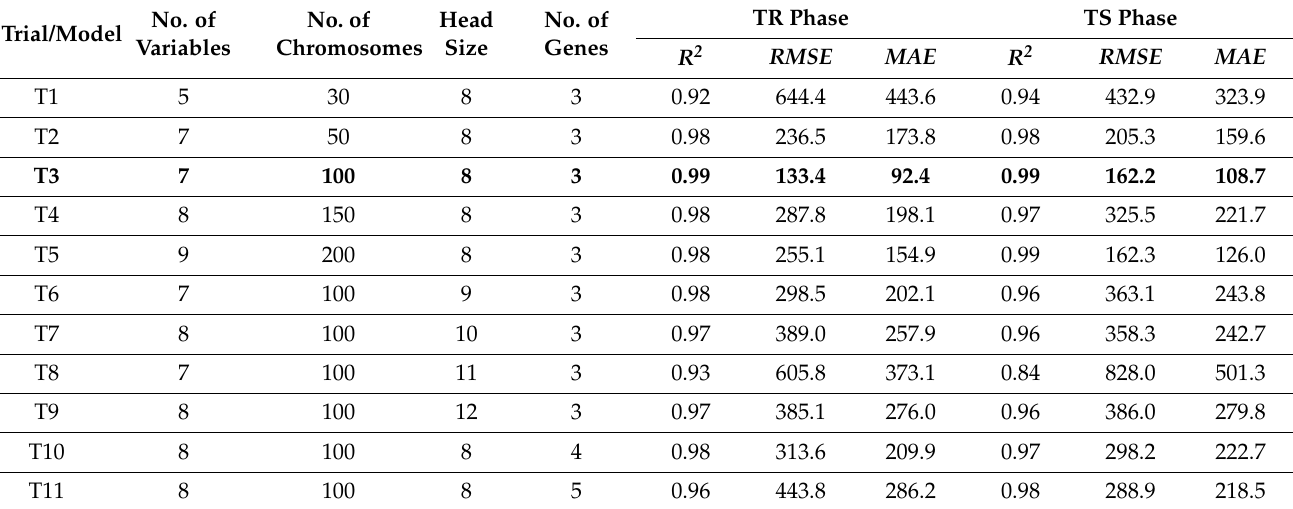
Table 4. Details of the different trials/models conducted to obtain optimal